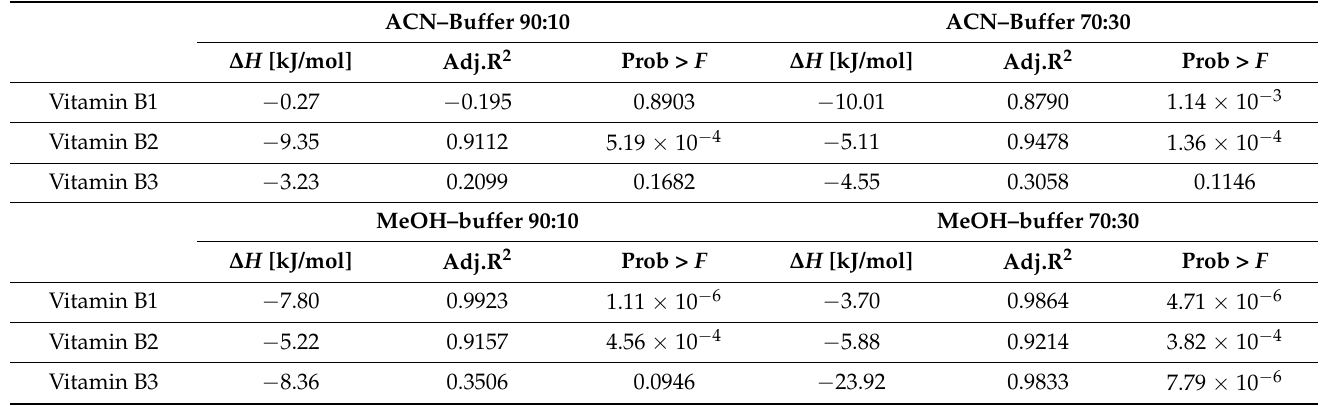
Table 3. Regression data of Van’t Hoff equation for analytes in column E for different mobile phase